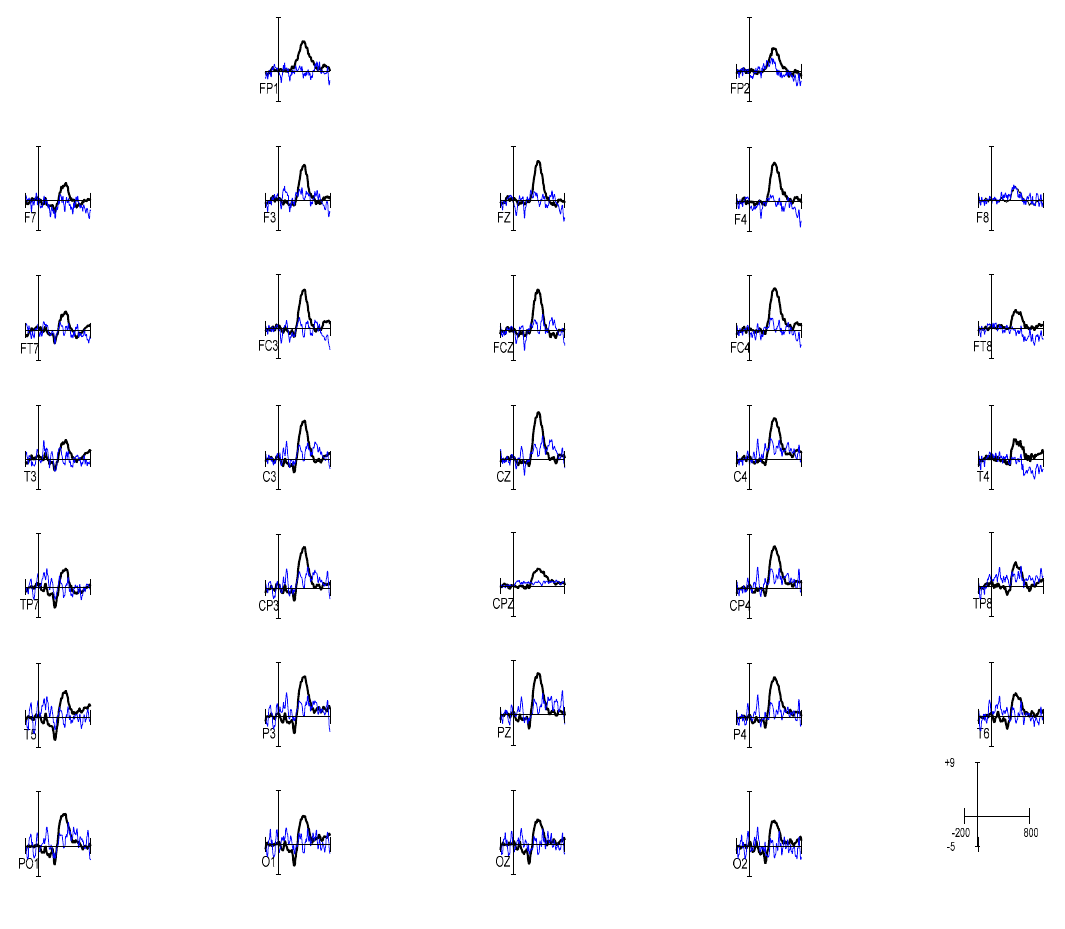
Figure 3. Grand average waveforms for the P3 subtraction wave (Match–Mismatch) for the Full Effort participants (black line) and the Malingering participants (blue line). Table 2. E ff ect of Group, Stimulus Type, and Accuracy on Mean P3 Amplitude at